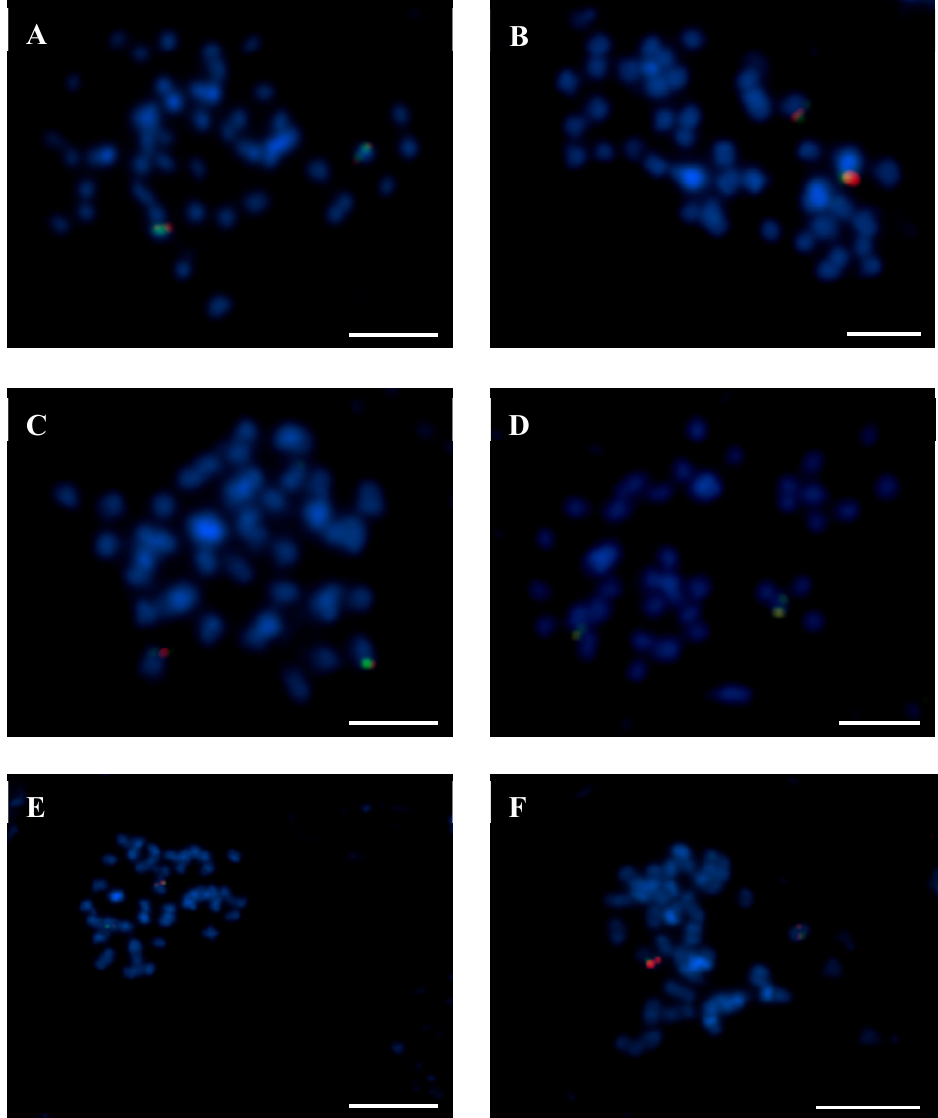
Figure 4. Identification of the Lang05-like chromosome in related lupins using fluorescence in situ hybridization (FISH) with BAC 131K22 (red signals) and BAC 4G15 (green signals). ( A ) L. albus . ( B ) L. pilosus . ( C ) L. palaestinus . ( D ) L. atlanticus . ( E ) L. digitatus . ( F ) L. cosentinii . Chromosomes were stained with DAPI (blue). Scale bars = 5 µm.